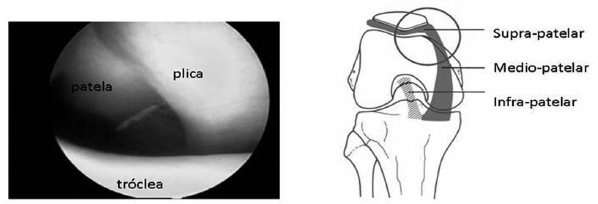
Figure 3 – Arthroscopic image of a mid-patellar synovial plica. The patella can be seen above the femoral trochlea, with a large mid-patellar plica interposed. In the drawing, the circle demonstrates the position of the arthroscopies